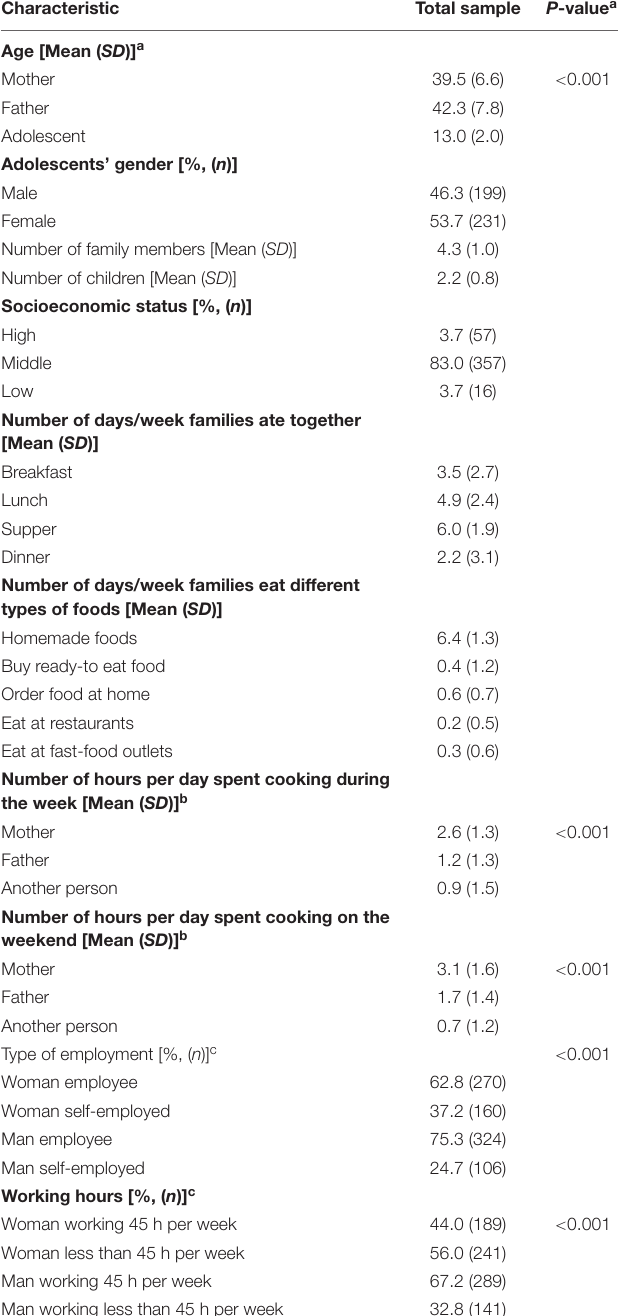
TABLE 1 | Sample characteristics ( n =